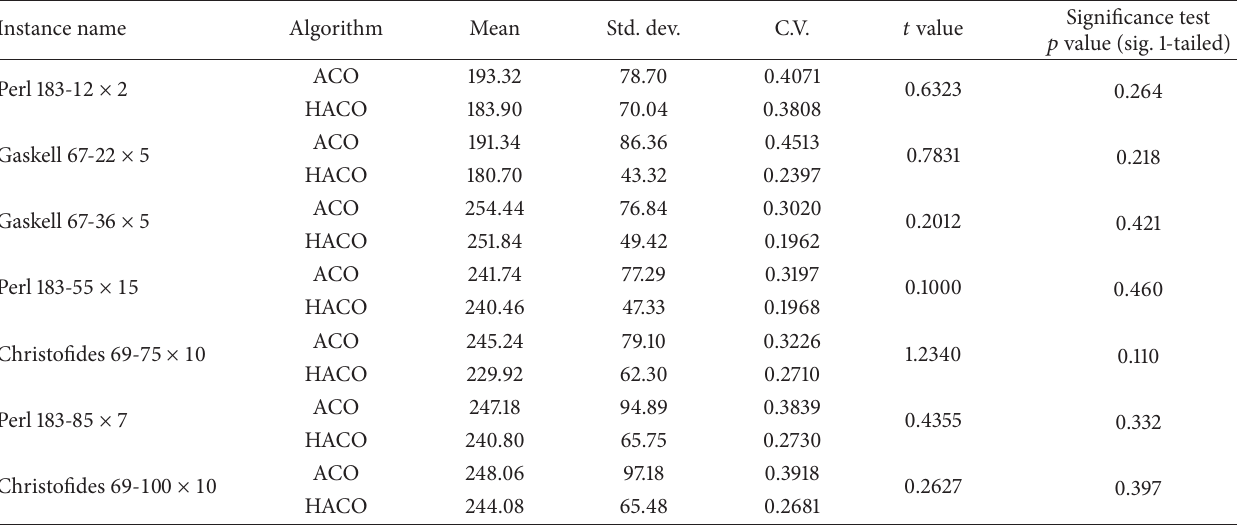
Table 10: Iterations of two algorithms